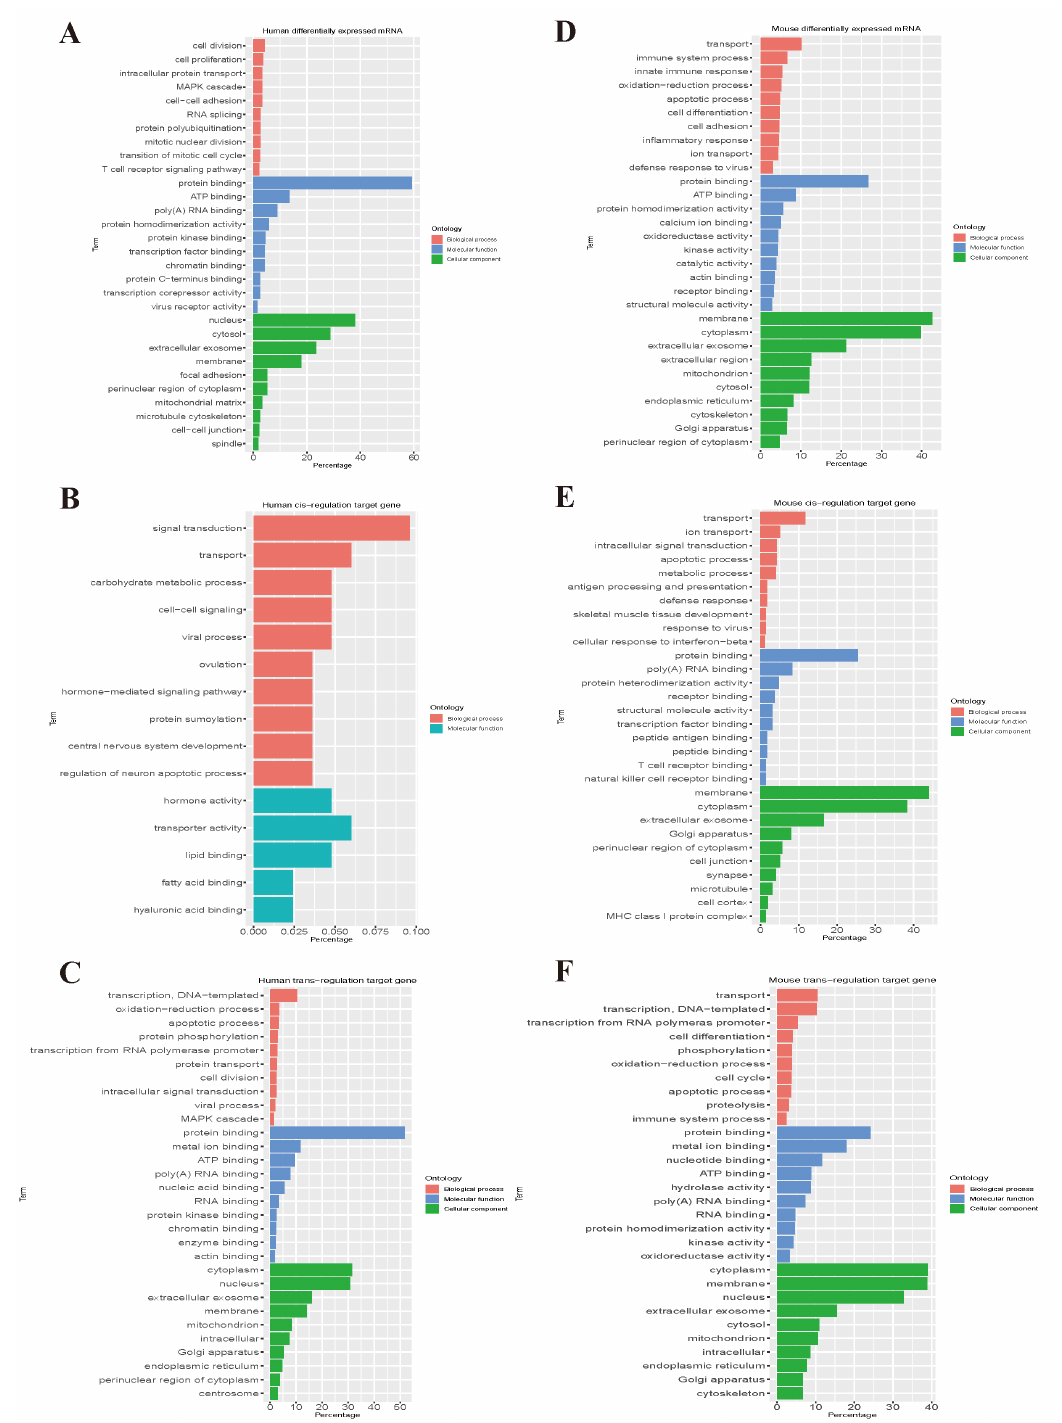
Figure 6. Gene ontology (GO) analysis for differentially-expressed genes upon EV71 infection. ( A – C ) The top 10 significantly enriched GO terms in differential expression of mRNA, cis - and trans -acting target mRNAs in EV71-infected RD cells, respectively. ( D – F ) The top 10 significant GO terms in differentially-expressed mRNA, cis - and trans -regulated genes in EV71-infected skeletal muscle of mice,